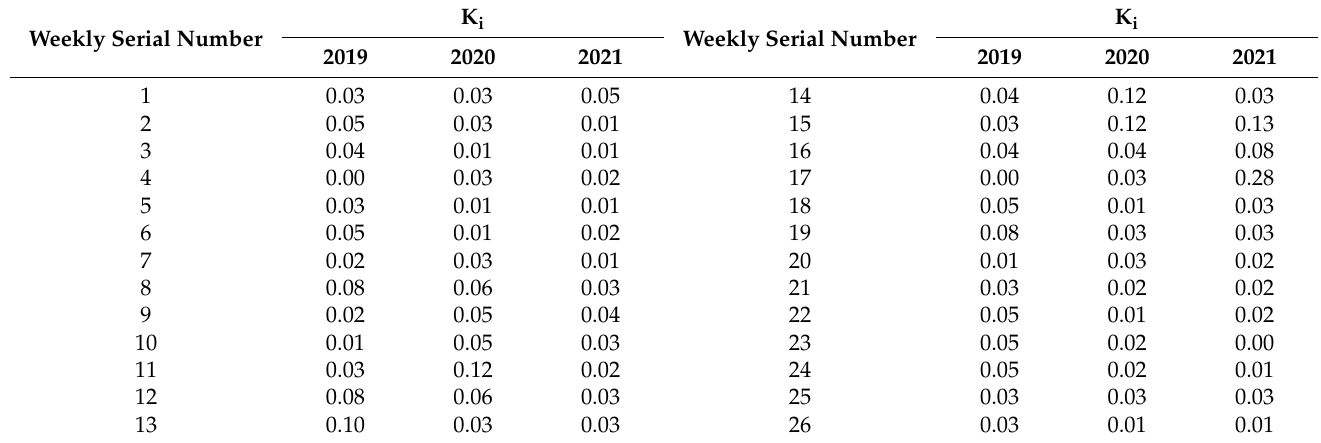
Table 9. Calculation results of the weekly system entropy weight of the NPTHN.